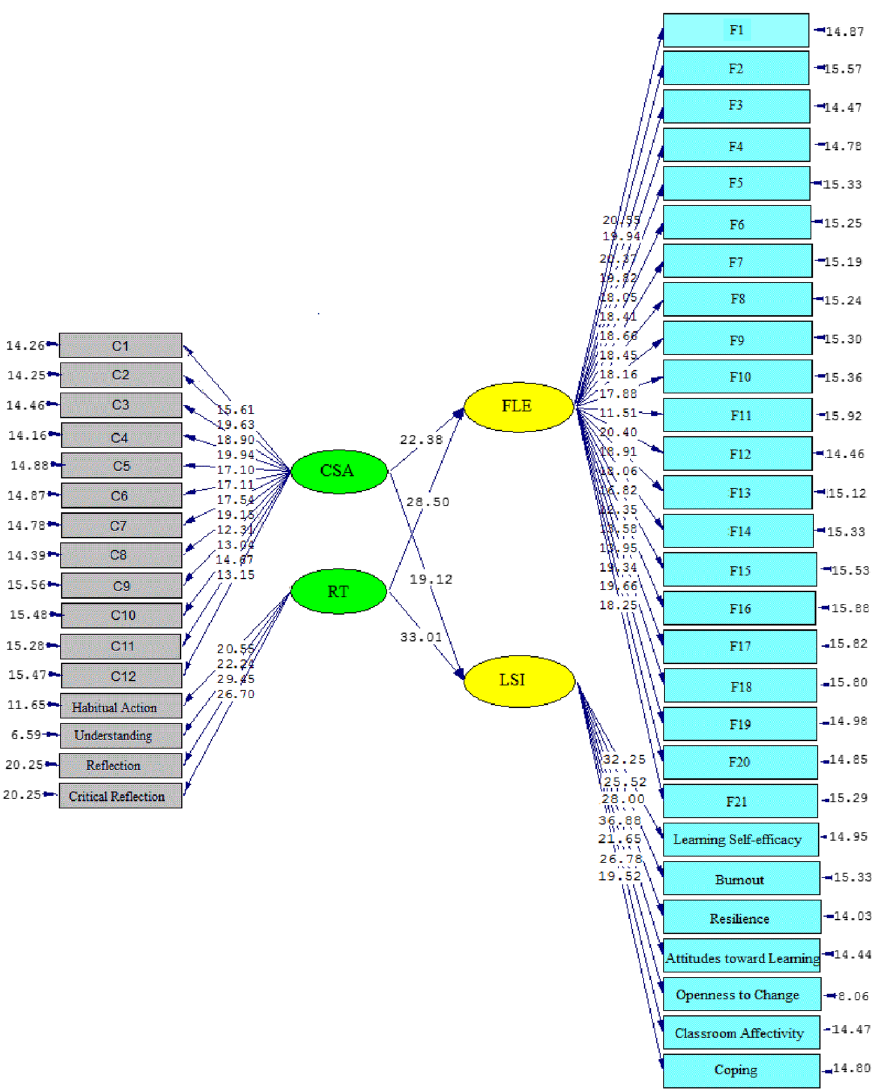
Fig. 3 T -values for path coefficient significance (model 1)